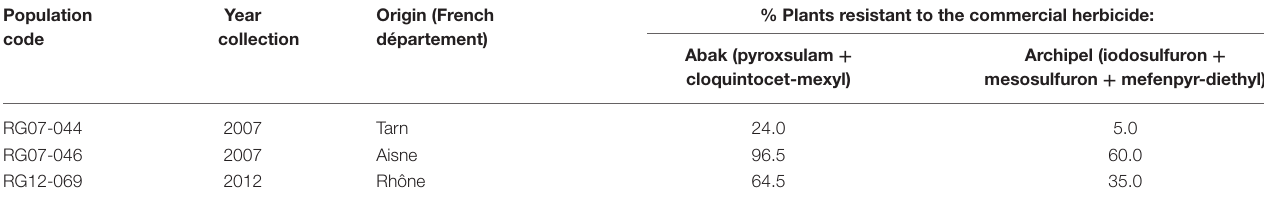
TABLE 1 | Field rye-grass populations studied. Population